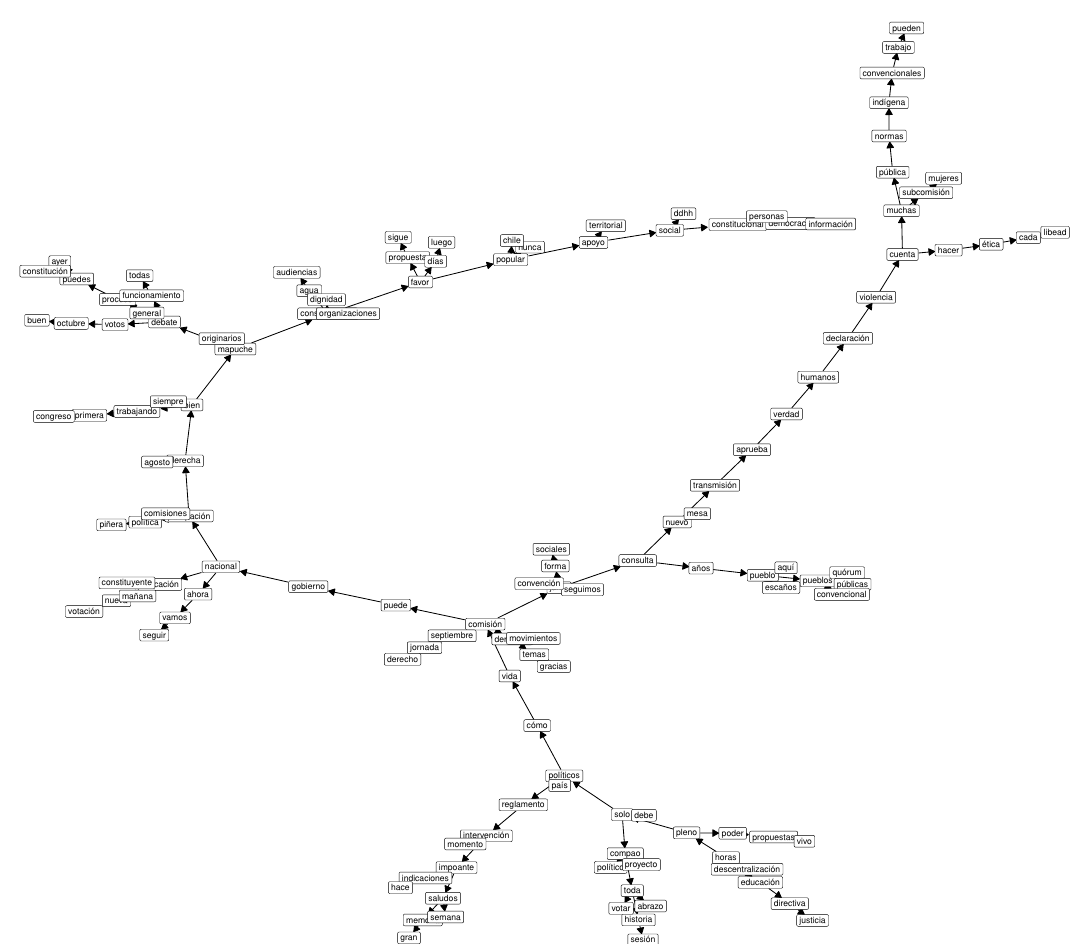
Figure 7. Examples of solutions achieved using ( µ , λ ) -TAN for the cluster 1